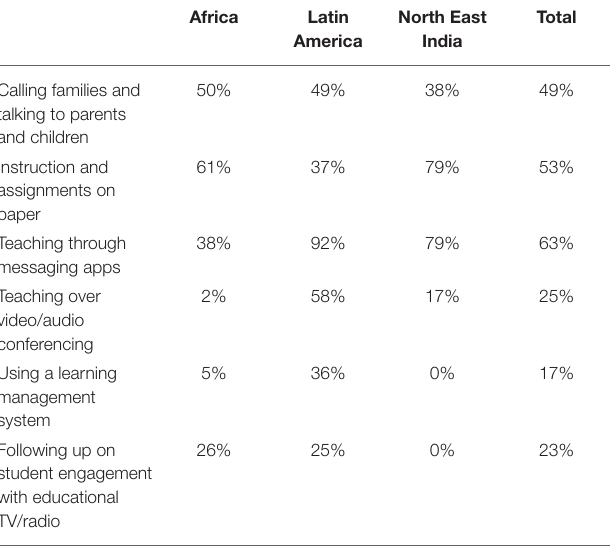
TABLE 6 | Types of educational support by geographic